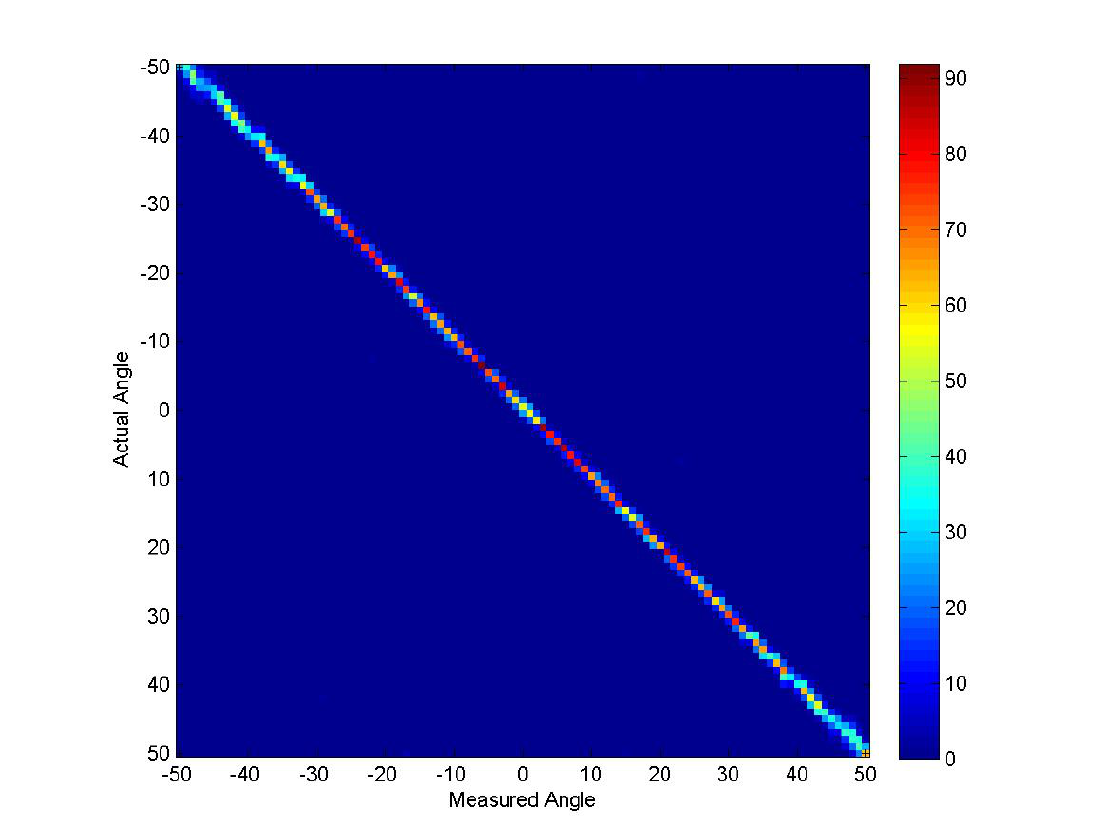
Figure 14. Experiment 5 beamforming relative gain envelope to the boresight (no threshold case).